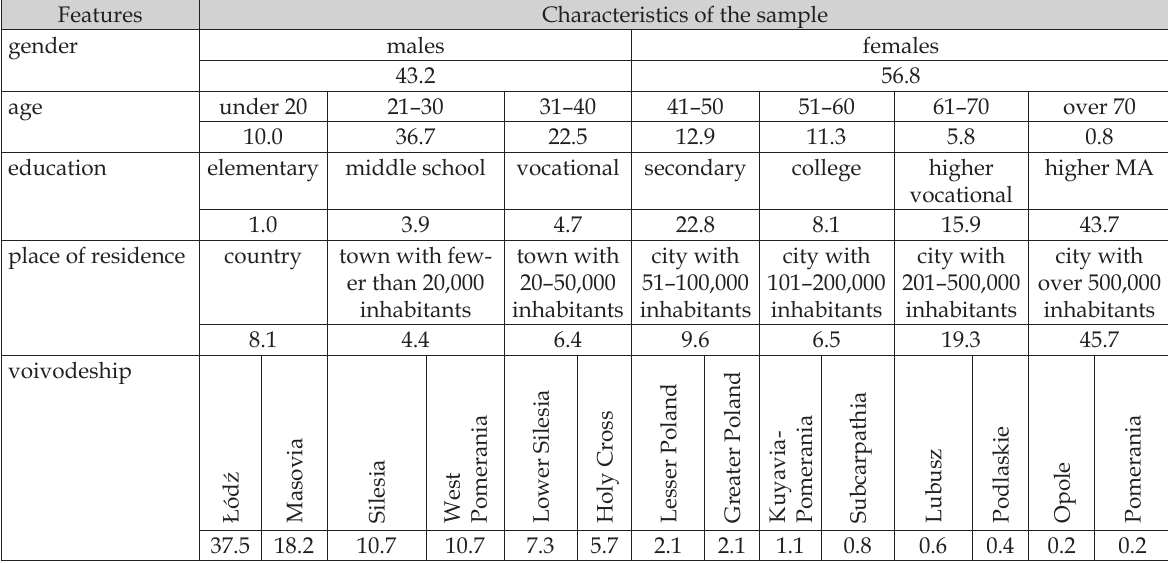
Fig. 2. Respondents’ visiting aim of the lubelskie Table 1 . Characteristics of the respondents [%].